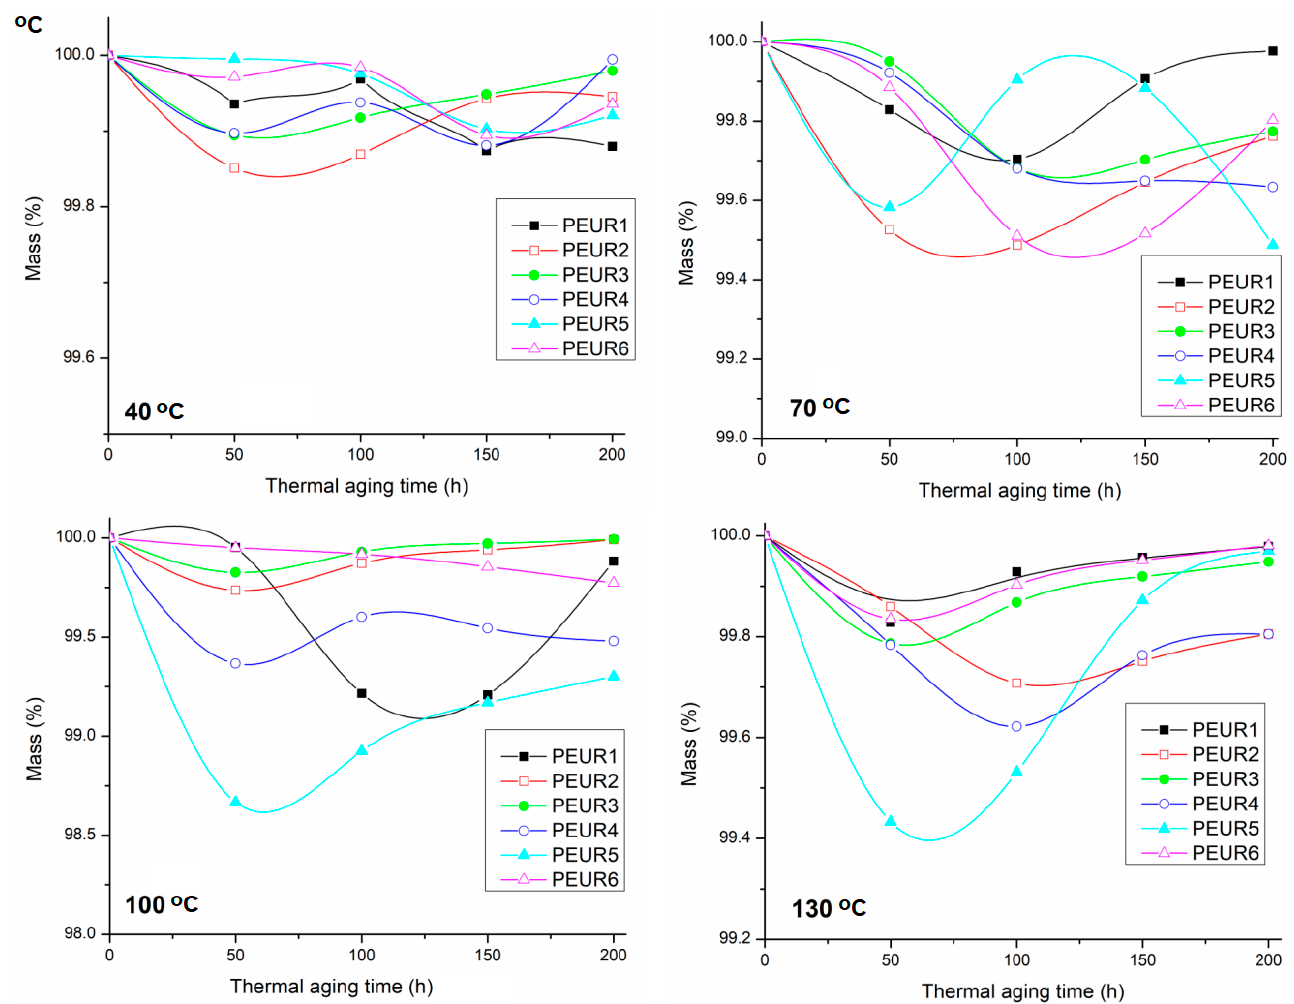
Figure 8. Evolution of mass variation of thermal aged PEURs at 40, 70, 100 and 130 °C.